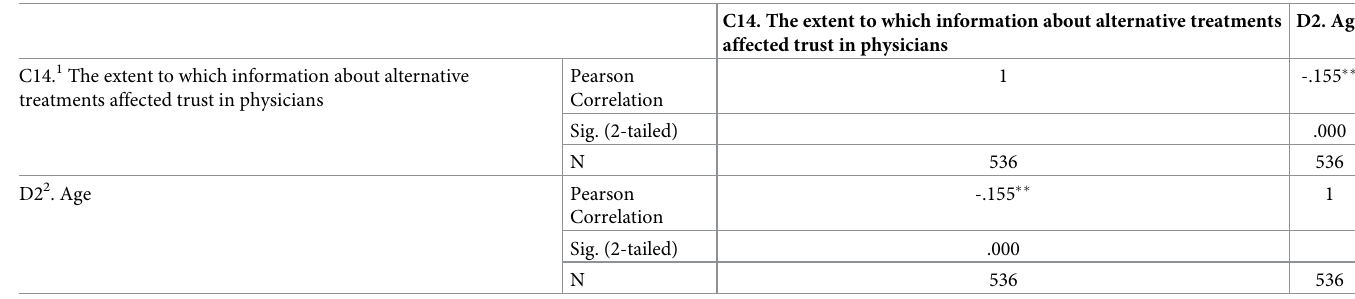
Table 3. Pearson correlation between information about alternative treatments and age.